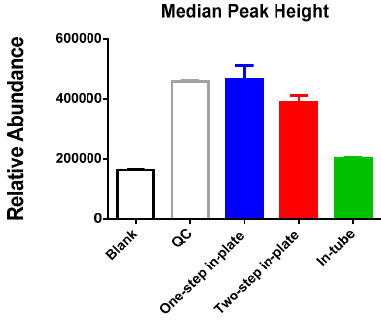
Figure 2. Comparison of global metabolite extraction efficiency: MDA-MB-231 cells were extracted using the “one-step in-plate”, ” two-step in-plate” or “in-tube” protocol (see Figure 1) and analysed on an LC-MS untargeted metabolomics platform. y- axis (relative abundance) represents the median peak height from all detected LC-MS peaks (mean ± SE; n = 3–4).